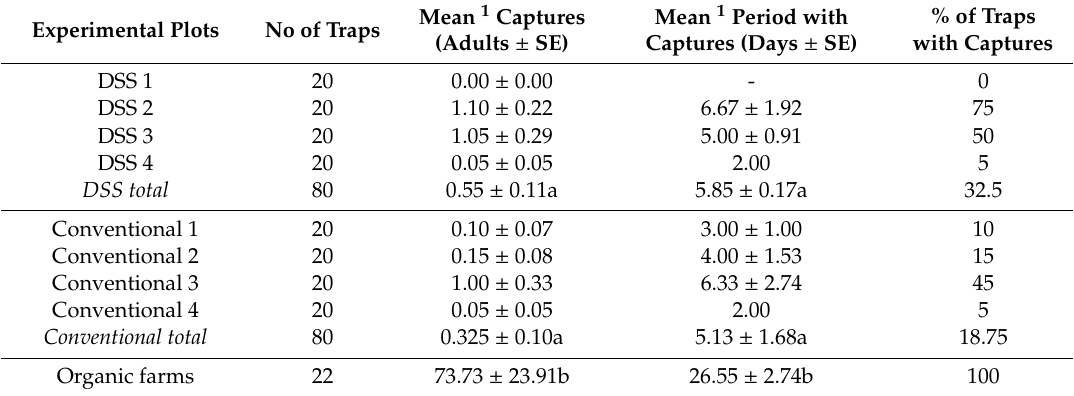
Table 4. Mean number of adult Rhagoletis cerasi captures and mean period with captures, per trap, in conventional and DSS plots of the commercial cherry orchards and in the reference organic farms during